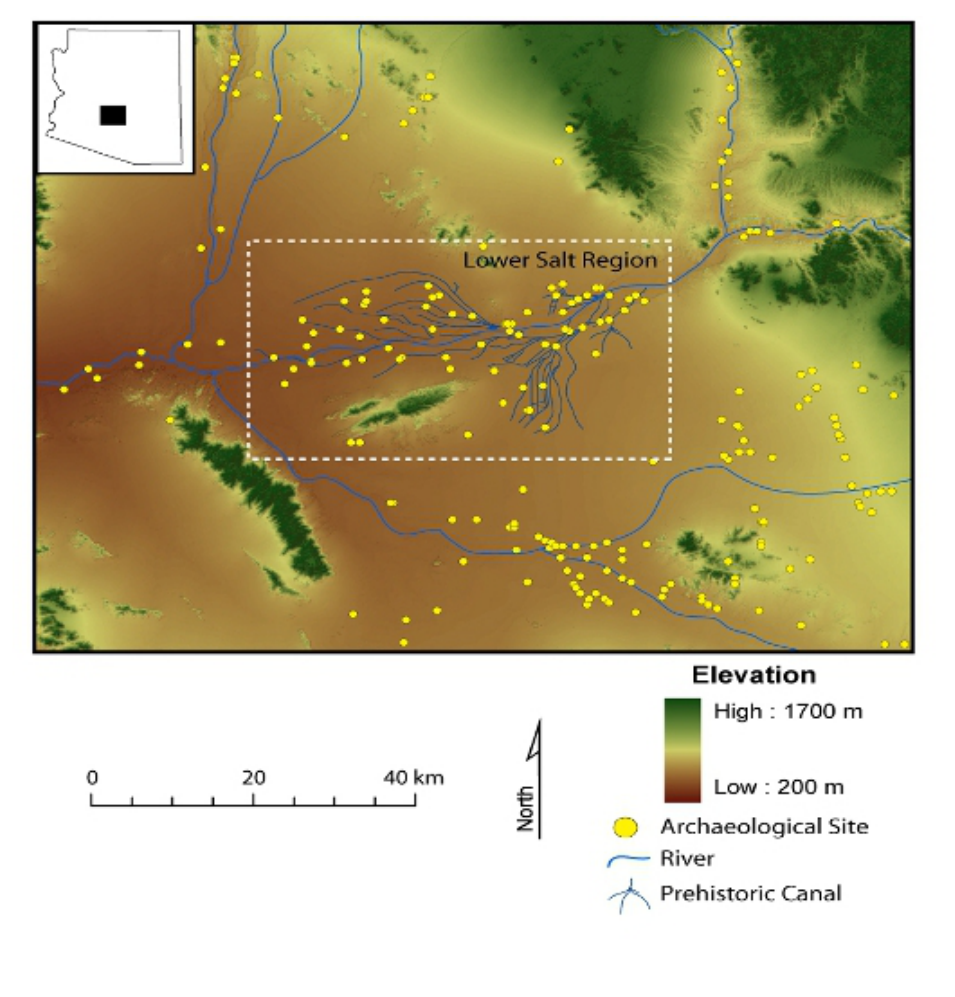
Fig. 8. Map of the Hohokam area, with landforms and